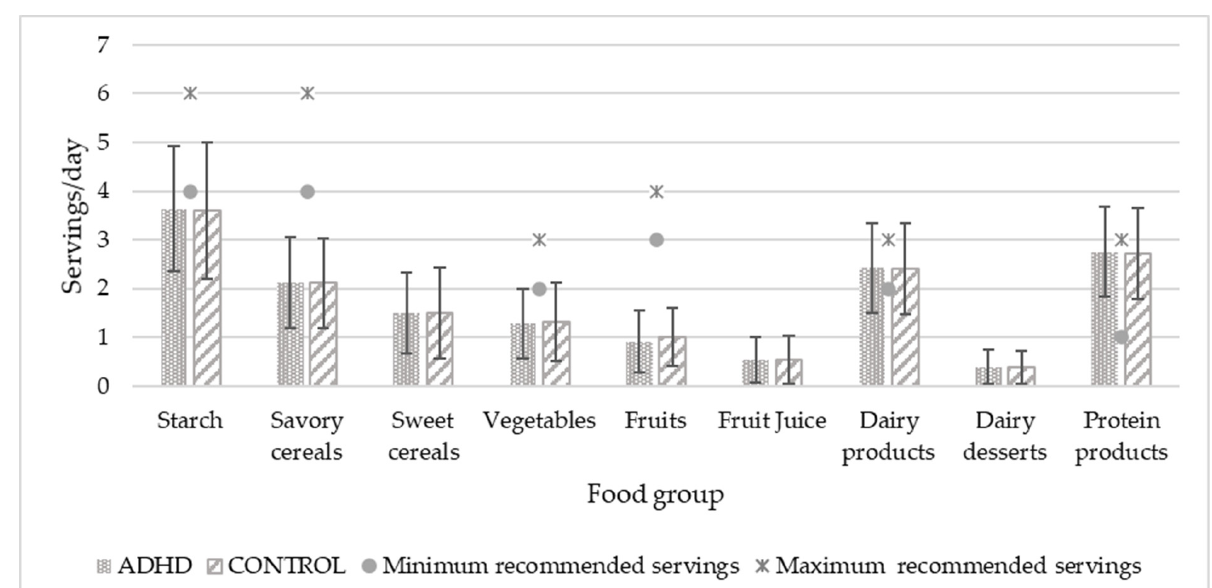
Figure 1. Daily food consumption of study population in relation to recommended servings. Serv- ings/day values are expressed by mean and standard deviation. Significant differences in fruit consumption are higher in the control group with p = 0.033. p < 0.05.